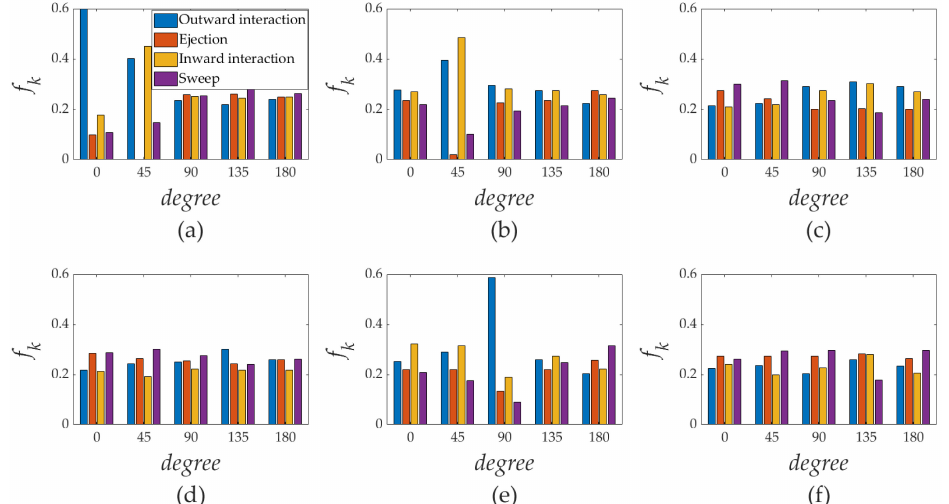
Figure 10. Frequency of occurrence of coherence turbulent events for: ( a ) Case 2 in vegetation areas ( y / B = 0.25); ( b ) Case 2 at interfacial areas ( y / B = 0.5); ( c ) Case 2 in non-vegetation areas ( y / B = 0.75); ( d ) Case 4 in non-vegetation areas ( y / B = 0.25); ( e ) Case 4 at interfacial areas ( y / B = 0.5); ( f ) Case 4 in vegetation areas ( y / B =